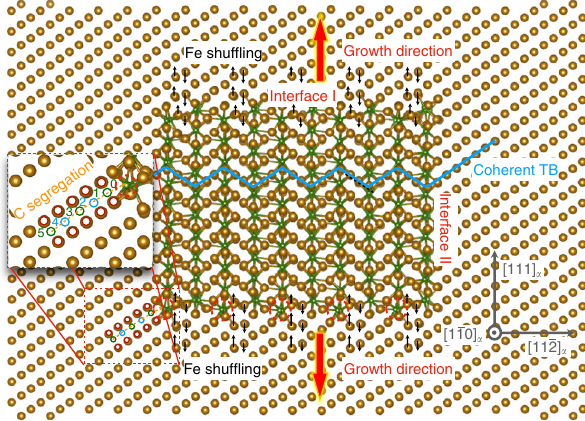
Fig. 3 Atomic structure of a cementite nanoprecipitate in ferrite matrix. A cross-section of the atomic structure of a nanoprecipitate of cementite in a bcc ferrite matrix within the Bagaryatsky orientation relationship relaxed using the Ruda EAM potential 26 . Gold spheres represent Fe atoms and green spheres refer to C atoms. Large colored arrows show the preferential growth direction of the precipitate, which is realized by a cooperative mechanism that combines a shuf fl e of the Fe lattice along the ±[111] α directions (small black arrows) and a segregation of C atoms (colored circles). The colored circles and their numbers refer to different interstitial sites for C. Light-blue lines highlight a coherent twin boundary (TB) between the bcc ferrite matrix and the cementite